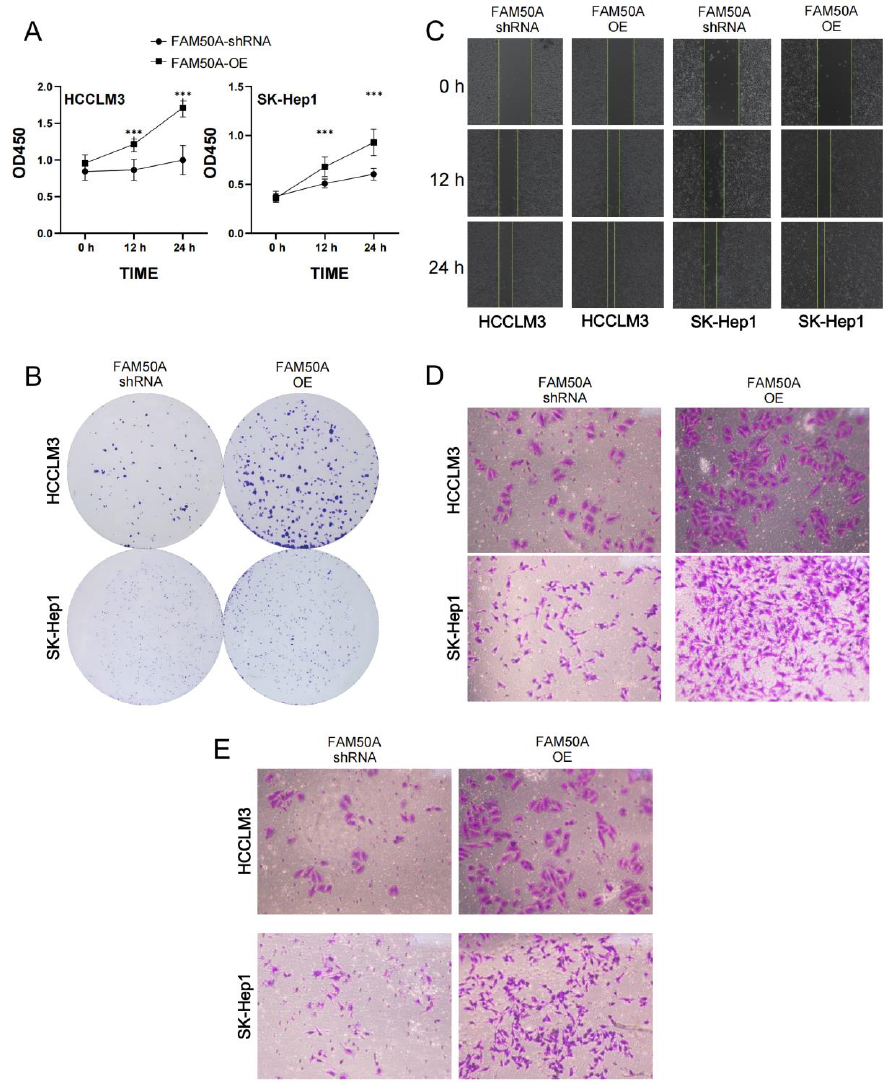
Figure 6. Effects of FAM50A on the proliferation, migration and invasion of HCC cells. ( A ) The proliferation capacity of FAM50A-shRNA-treated cells and FAM50A-OE cells, determined by Cell Counting Kit-8 (CCK-8) assay. The broken line graph shows the cell growth. ( B ) The proliferation ability of FAM50A-shRNA-treated cells and FAM50A-OE cells was determined by colony formation assay. Cell colonies were stained with crystal violet. ( C ) The cell migration ability of FAM50A-shRNA-treated cells and FAM50A-OE cells was determined by wound healing assay. The blank space between the two lines reflects the extent of cell migration. ( D ) The cell migration ability of FAM50A-shRNA-treated cells and FAM50A-OE cells was determined by the transwell assay. The cells were stained with crystal violet. ( E ) The invasion ability of FAM50A-shRNA-treated cells and FAM50A-OE cells was determined by transwell assay with the addition of matrix gel. The cells were stained with crystal violet. *** P < 0.001.